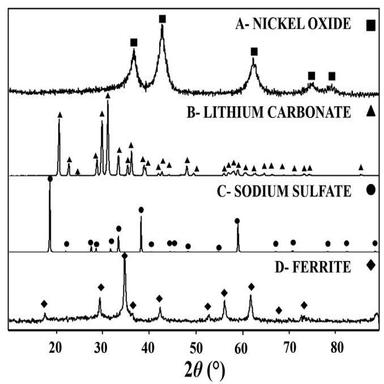
XRD patterns of NiO (pattern A), Li2CO3 (pattern B), Na2SO4 (pattern C) and Mn(1−x)CoxFe2O4 nano-powder (pattern D).